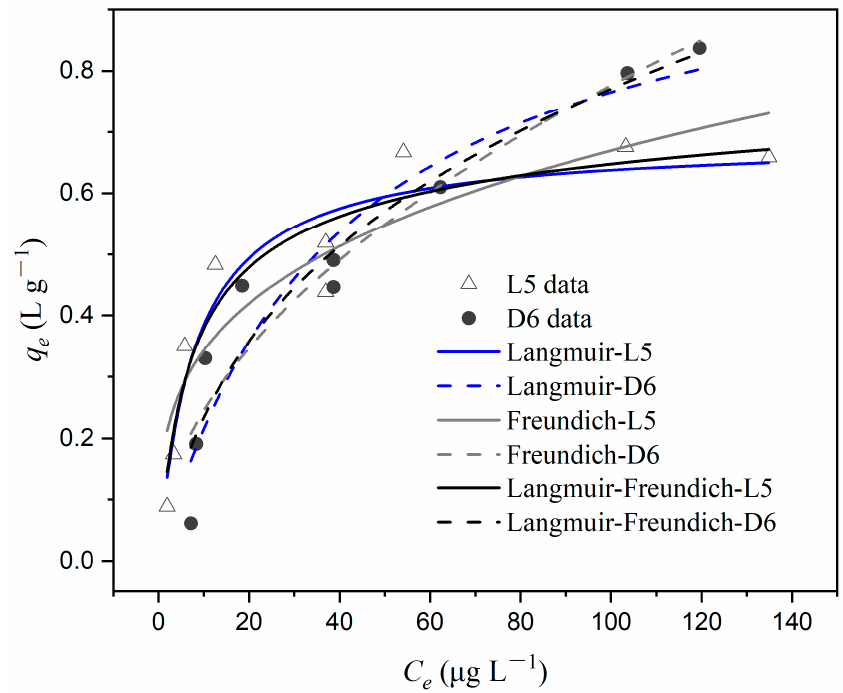
Figure 4. Isotherm for adsorption of L5 and D6 on MSW (conditions: V = 50 mL; L5 concentration = 20 ppb; MSW dosage = 10 g; T = 298 K).